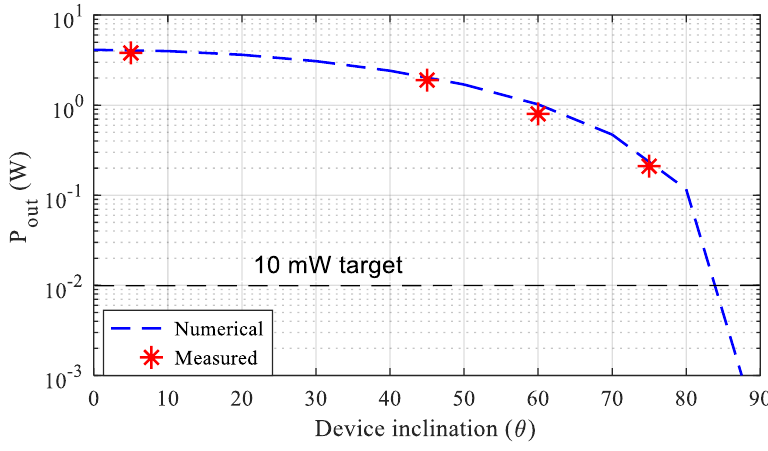
Figure 19. Measured output voltage V out .